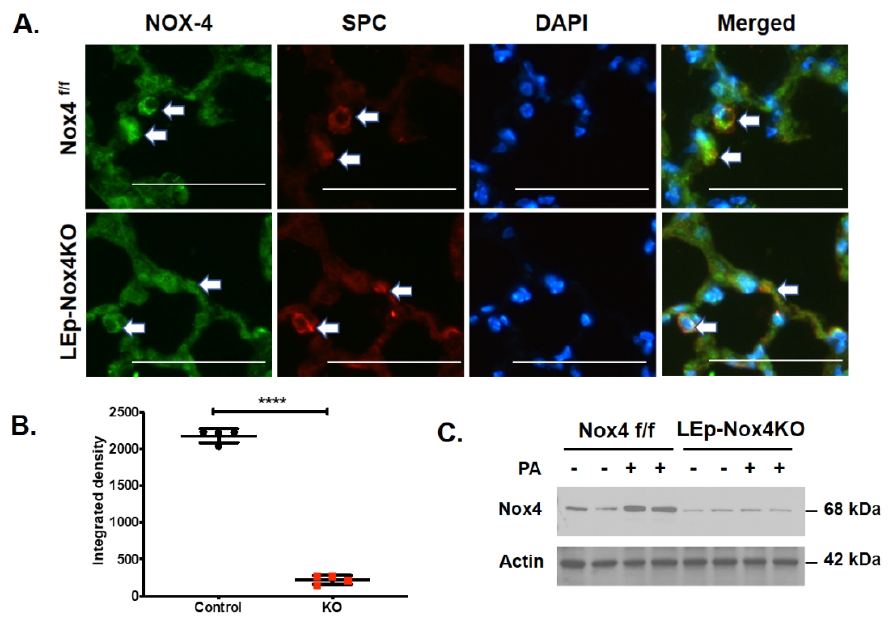
Figure 2. NADPH Oxidase 4 (NOX4) expression is downregulated in lungs and isolated alveolar epithelial cells from LEp-Nox4 knock out ( KO ) mice. ( A ) Lungs from tamoxifen-treated Nox4 flox/flox and LEp-Nox4 knock out ( KO ) mice were removed, fixed, and embedded in paraffin, as described under experimental procedures. Cut 5 μ m lung sections were subjected to immunofluorescence staining for NAPH Oxidase 4 (NOX4) (green), surfactant protein C (SPC) (red), and nuclear staining with 4 ′ ,6-diamidino-2-phenylindole (DAPI) (blue). Shown is a representative micrograph of co-localization of NOX4 and SPC (merge of green and red) with the alveolar type 2 pneumocytes indicated with arrows. Co-localization of NOX4 (green) and SPC (red) seen in lungs of Nox4 flox/flox mice, but not in LEp-Nox4 -deficient mice. The white triangular arrows highlight the NOX4-SPC colocalized areas in the image. Shown is a representative micrograph, Scale bar, 100 μ m. ( B ) Quantification of merged images of NOX4 (green) and SPC (red) of the micrographs from ( A ). **** p < 0.005. ( C ) Nox4 flox/flox and LEp-Nox4 KO mice ( n = 5) were challenged intratracheally with sterile PBS or P. aeruginosa ( PA ) (1 × 10 6 CFU/mouse) for 24 h as indicated in Figure 1. Lungs were lavaged, and lung tissue lysates (30 μ g protein) were subjected to sodium dodecyl sulfate-polyacrylamide (SDS-PAGE) and Western blotting, and immunostained for NOX4 and actin using specific antibodies. Shown is a representative blot from three independent experiments.